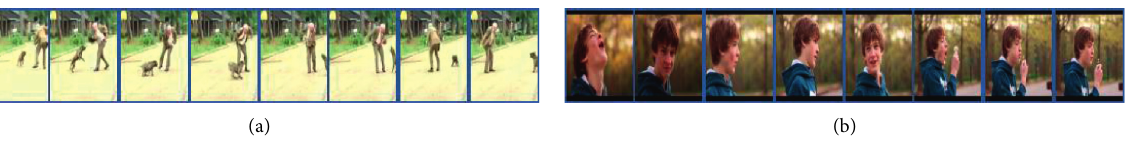
Figure 1: Illustration of information combination.